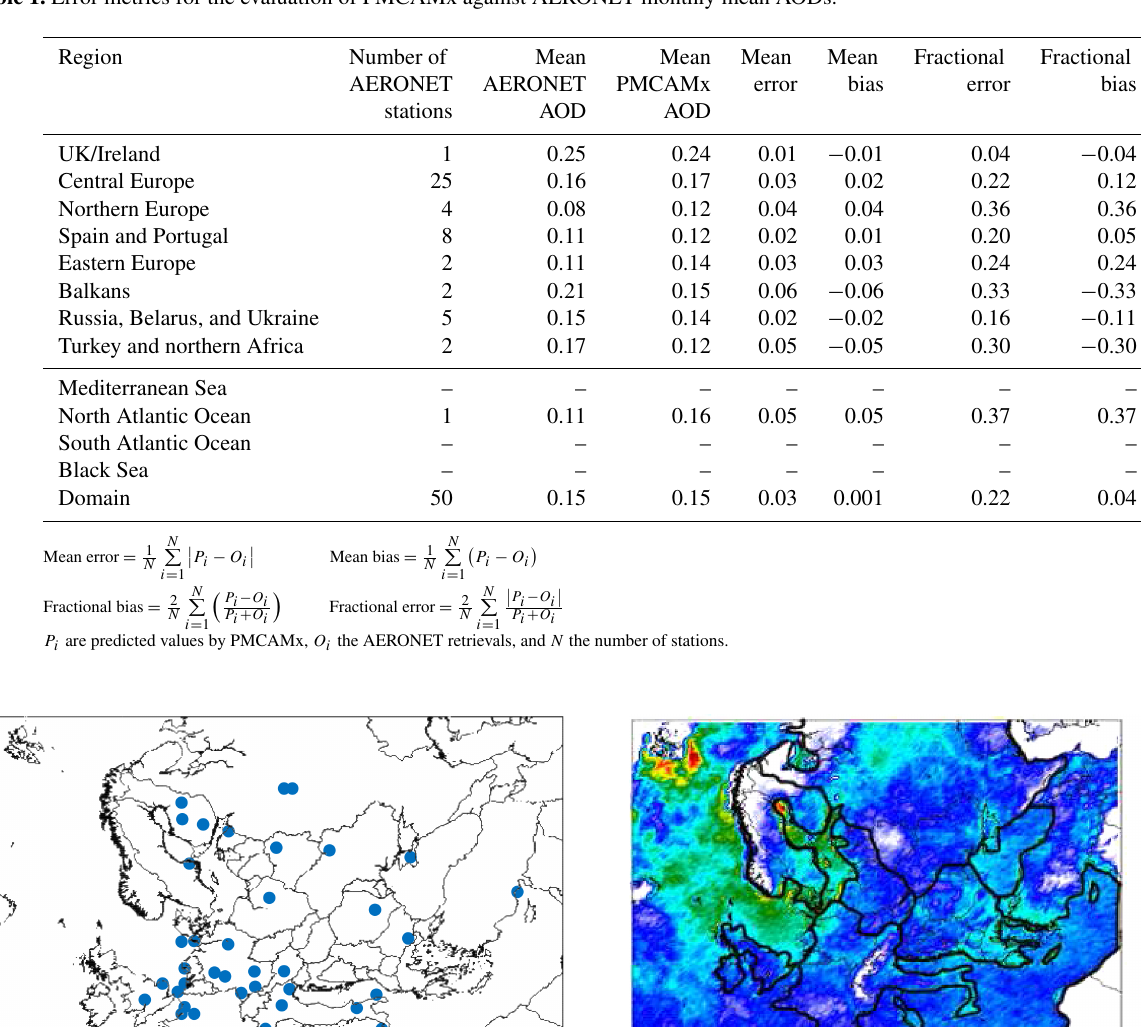
the corresponding fraction that needs to be discarded due to dust influence. The location of the AERONET stations also contributes to this